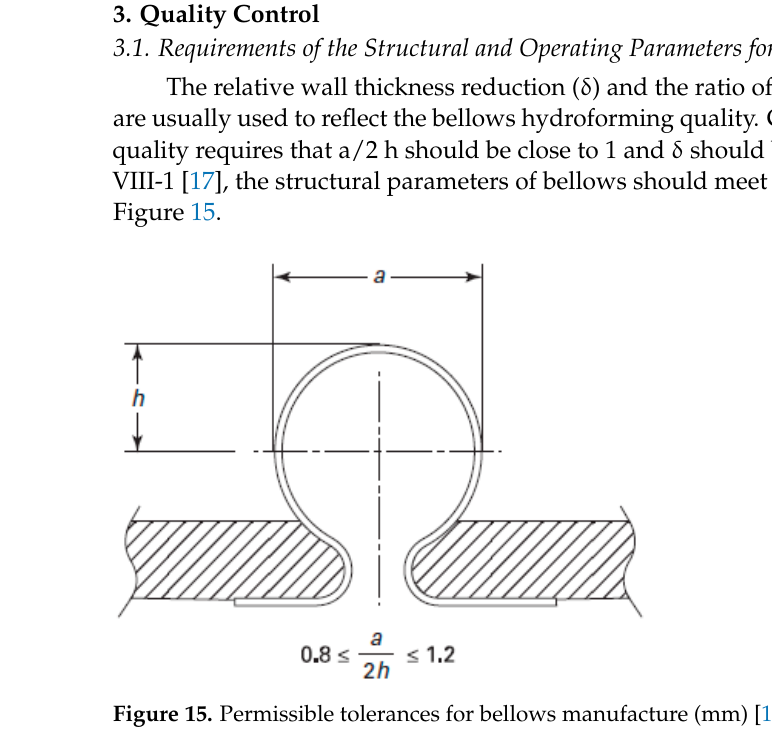
strength of tube blank at ordinary temperature; D b : inner diameter of tube blank; P 1